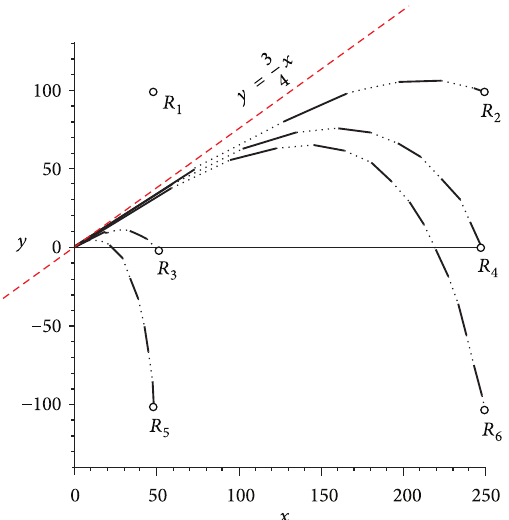
Figure 12: Planning trajectories through six different targets, all starting with the slope 3/4.